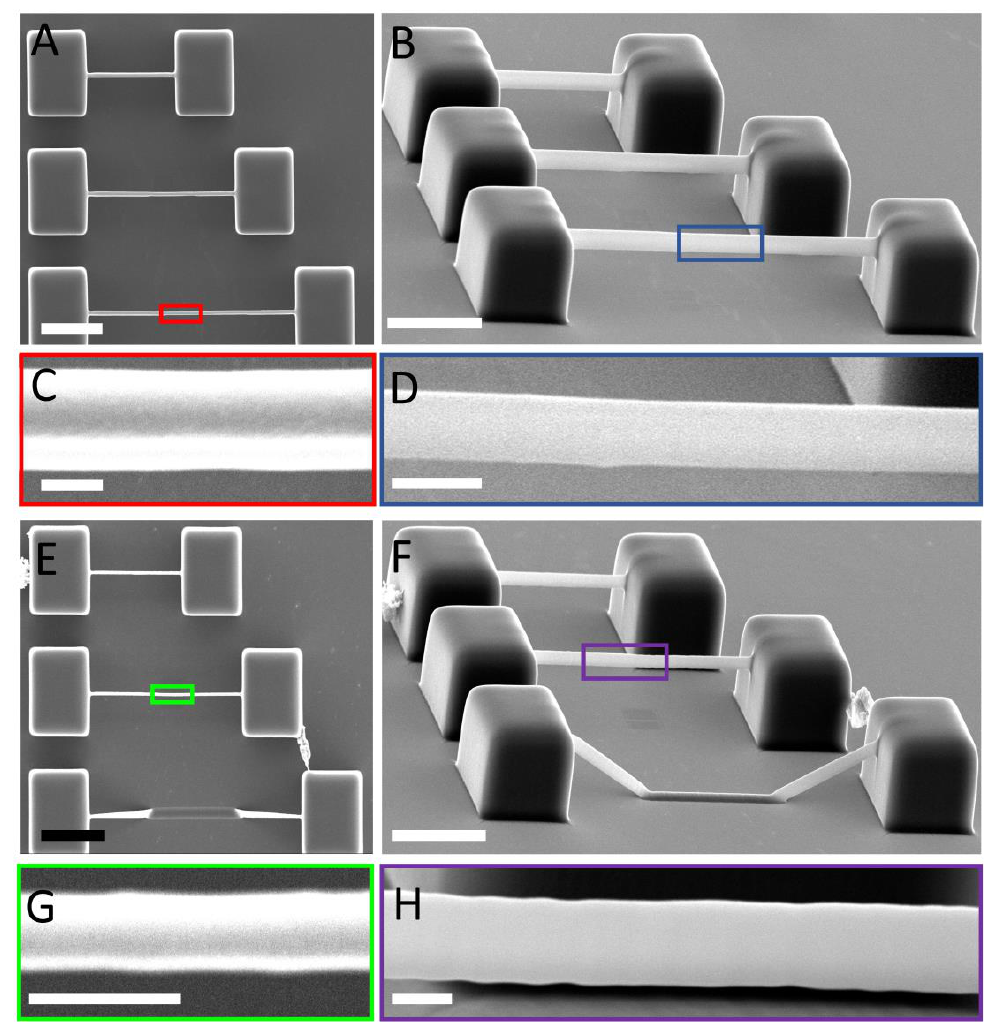
Figure 5. Representative SEM micrographs of 2PP-printed IP-PDMS beams. ( A ) Top view of beams with nominal lengths of 30, 50, and 70 µ m and a nominal width of 1 µ m (hatching distance of 0.25 µ m, laser power of 45 mW, and scan speed of 3 mm/s; scale bar = 20 µ m). ( B ) Tilt view of 65 degrees of the beams in A (scale bar = 20 µ m). ( C ) Top view close-up of the beam with a length of 70 µ m. The beams printed with these settings have an average width of 1.46 ± 0.11 µ m (n = 3; scale bar = 1 µ m). ( D ) Sixty-five-degree tilt view of the side of the printed beam indicated in B. The measured thickness of the beam is 4.49 ± 0.05 µ m (n = 3; scale bar = 5 µ m). ( E ) Top view of beams with nominal lengths of 30, 50, and 70 µ m and a nominal width of 1 µ m (hatching distance of 0.3 µ m, laser power of 42.5 mW, and scan speed of 4.5 mm/s; scale bar = 20 µ m). Note the 70 µ m beam collapsed. ( F ) Tilt view of 65 degrees of the same beams as in E (scale bar = 20 µ m). ( G ) Top view close-up of the beam with a length of 50 µ m. The beams printed with these settings have an average width of 1.03 ± 0.02 µ m (n = 3; scale bar = 2 µ m). ( H ) Sixty-five-degree angle view of the side of the printed beam indicated in F. The measured thickness of the beam is 3.00 ± 0.06 µ m (n = 3; scale bar = 2 µ